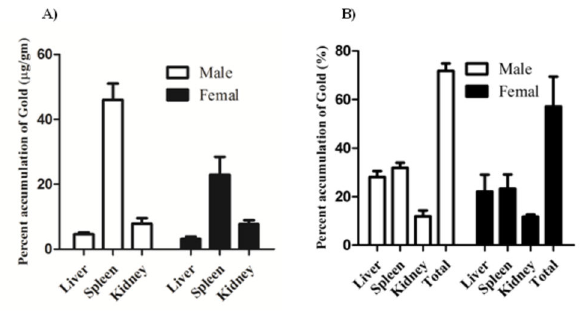
Figure 3. Tissue accumulation of GNRs after repeated I.V. administration to male and female normal animals. GNRs were administered by I.V. injection (0.1 mg/kg for five consecutive days of each month and repeated for 6 months). Three week after the last injection major target organs (liver, spleen, kidney and brain) were assayed for tissue concentration of GNRs (A) and the percent residual amount of the total administered dose (B). Data are presented as mean ± SEM